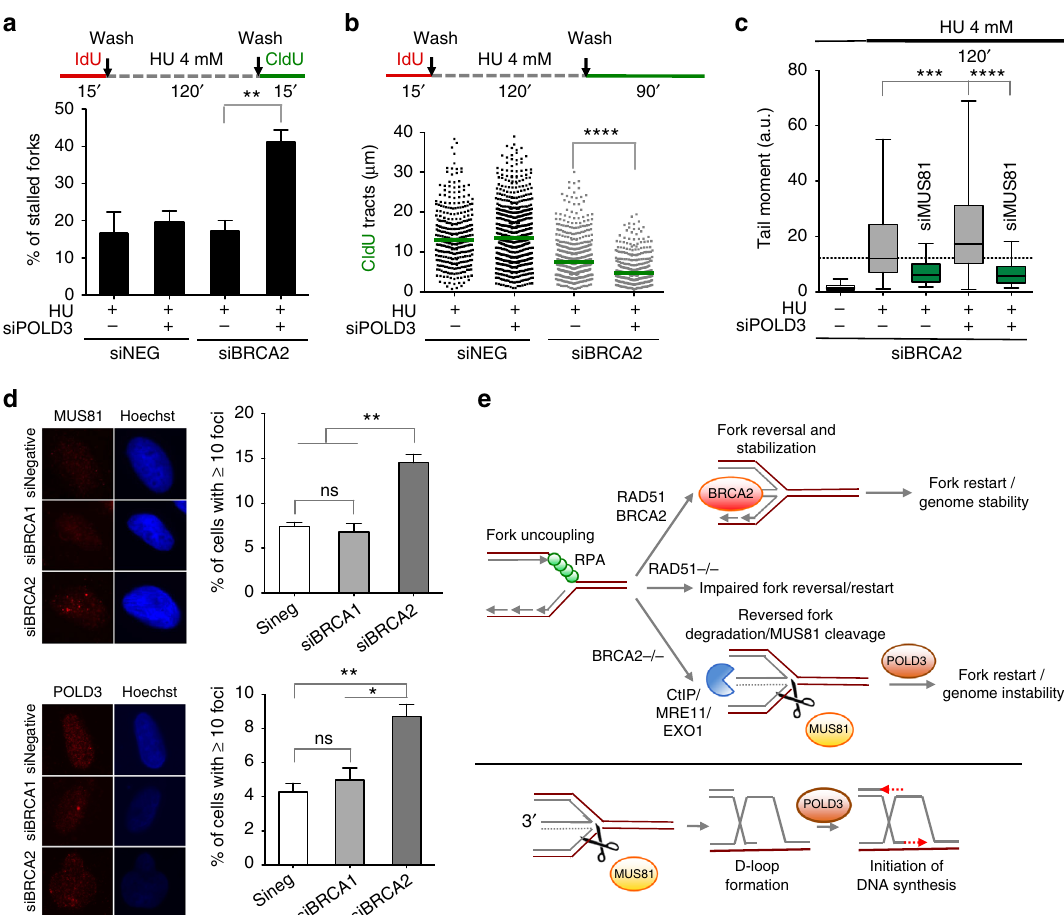
Fig. 6 POLD3 is required to restart resected forks in BRCA2-de fi cient cells. a Quanti fi cation of restarting forks in BRCA2-de fi cient and -pro fi cient U2OS cells with or without POLD3 siRNA knockdown. Out of 2 repeats, the percentage is established on at least 250 tracts scored for each data set. Mean shown. Errors, S.E.M. Statistics: unpaired t test; ** P < 0.01. b Size distribution of CldU tract length in U2OS cells transfected with control siRNA (siNEG), POLD3 siRNA, or BRCA2 siRNA before IdU and CldU labeling. Out of 3 repeats; n ≥ 150 tracts scored for each data set. Bars represent the median. Statistics: Mann – Whitney; **** P < 0.0001. c Neutral Comet assay monitoring DSB formation upon POLD3 depletion in BRCA2-de fi cient cells. Cells were transfected with control siRNA (siNEG), BRCA2 siRNA, MUS81 siRNA, or POLD3 siRNA. Out of 2 repeats; n ≥ 200 comets scored for each data set. Whiskers the 10th and 90th percentiles. *** P < 0.001: **** P < 0.0001 (Mann – Whitney test). d Left, representative images of MUS81 and POLD3 foci observed upon HU treatment. Scale bar, 10 μ m. U2OS cells were transfected with control siRNA (siNEG), BRCA1 siRNA, or BRCA2 siRNA and processed for immuno fl uorescence. Right, quantitation of MUS81 and POLD3 foci. Out of 3 repeats; n ≥ 150 cells scored for each data set. Mean shown. Errors, S.E.M. Statistics: unpaired t test; * P < 0.05; ** P < 0.01. e Top, roles of BRCA2, CtIP/MRE11/EXO1 and MUS81/POLD3 in reversed fork protection, degradation and cleavage/restart, respectively. Genotoxic agents lead to fork uncoupling and reversal. Reversed forks are stabilized by BRCA2, allowing accurate fork restart and genome stability. BRCA1 shares a similar function in reversed fork stabilization. RAD51 loss prevents fork reversal and compromises fork restart and cell viability. BRCA2 loss leads to CtIP/MRE11/EXO1-mediated degradation of the reversed replication forks. MUS81 cleaves the partially resected reversed forks with a ssDNA fl ap to grant POLD3-dependent fork restart and cell survival. Bottom, the MUS81 endonuclease cleaves the resected reversed forks with a ssDNA fl ap and lead to the subsequent formation of a D-loop structure that would in turn initiate POLD3-dependent DNA synthesis